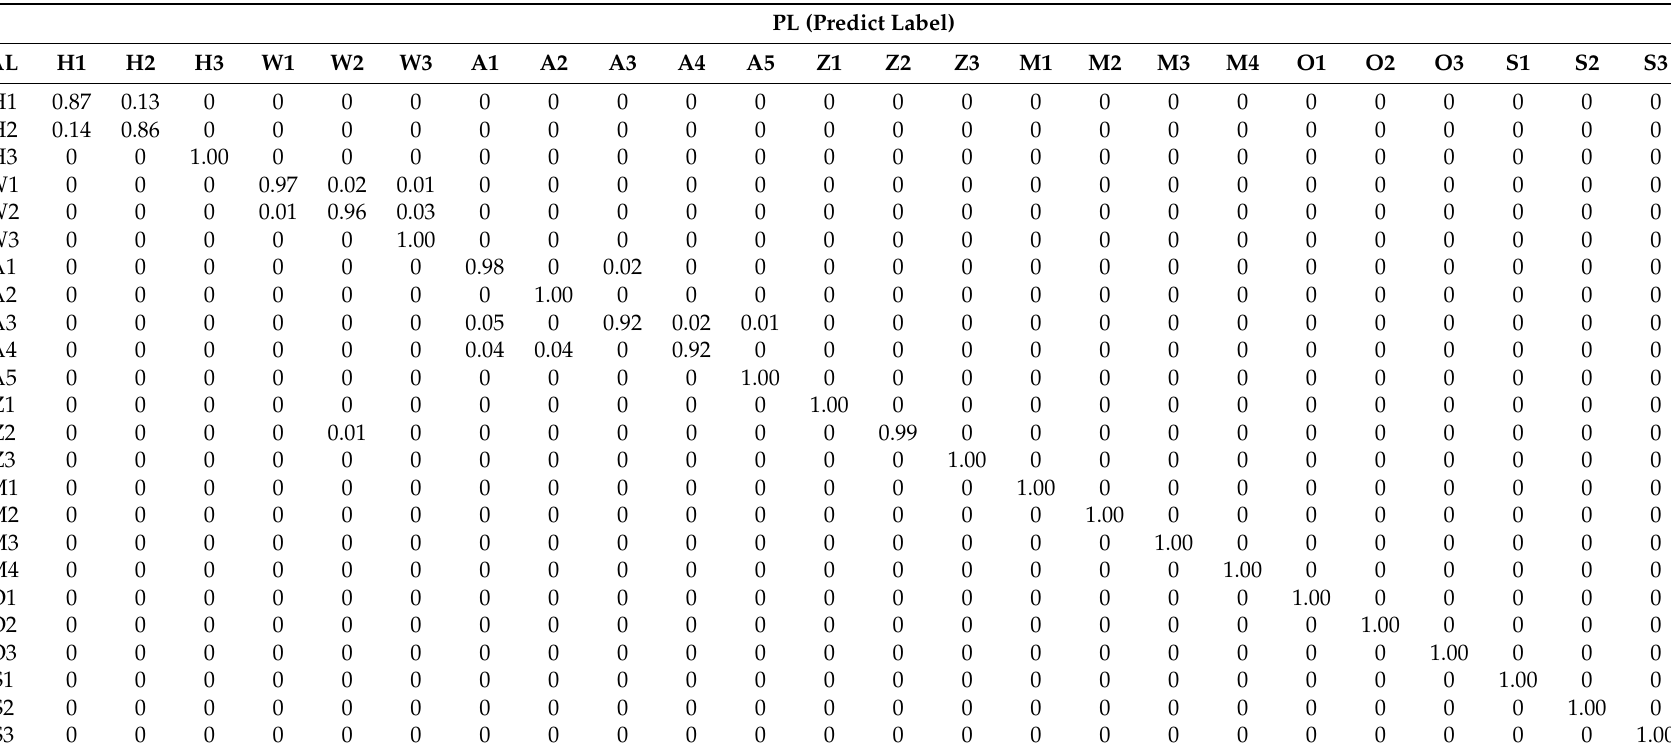
Table 3. Specific classification results of SSF (CQT) for the clean test set